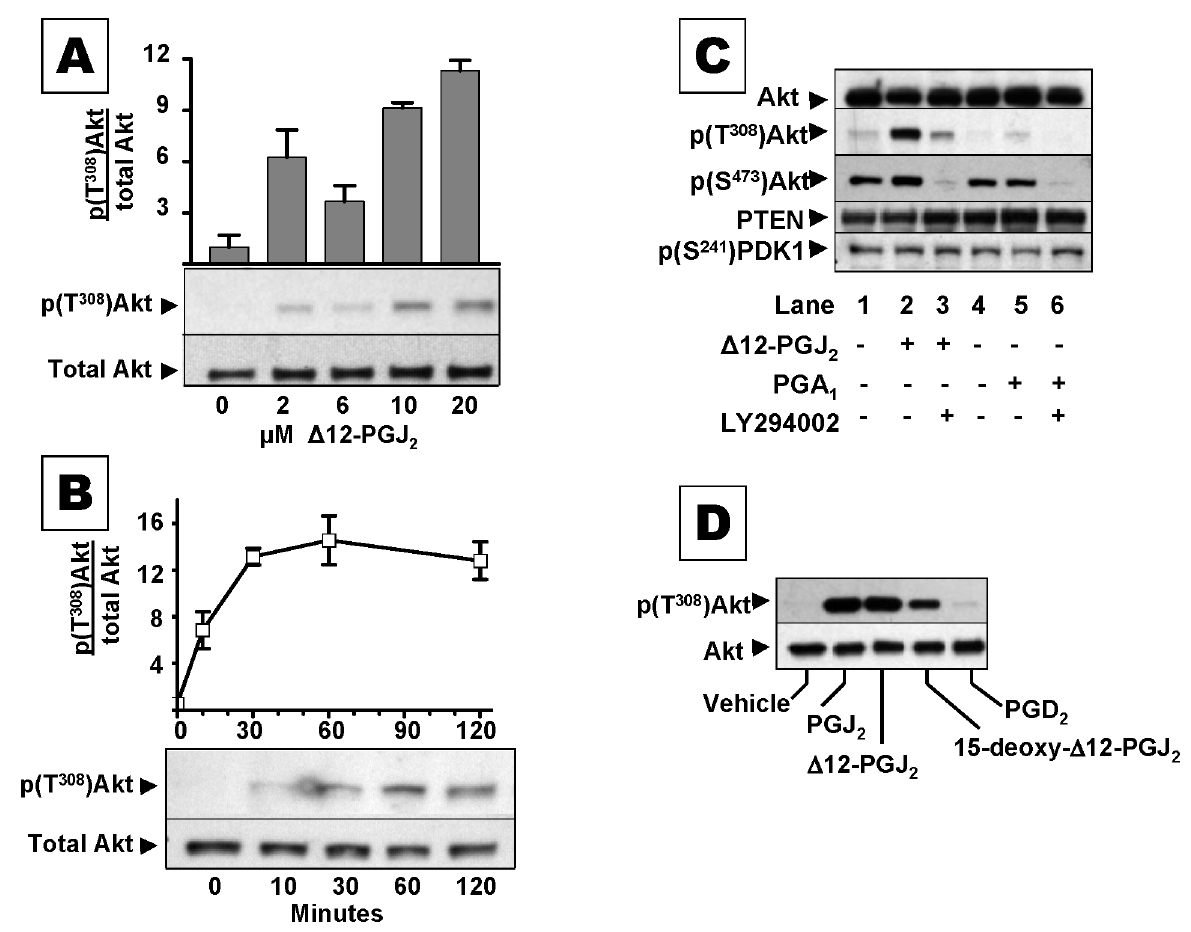
Figure 3. The a , ß–unsaturated enone D 12PGJ 2 interferes with PTEN suppression of Akt activation. ( A ) Immunoblots of phospho- (T 308 )Akt relative to total Akt in lysates from MCF-7 cells treated 30 min with 0–20 m M D 12-PGJ 2 . The bar graph shows the increase in phospho- (T 308 )Akt/total Akt (mean 6 s.e.m) from n $ 3 separate experiments. ( B ) Immunoblot of phospho-(T 308 )Akt relative to total Akt in lysates from MCF-7 cells treated with 20 m M D 12-PGJ 2 for 0–120 min. The bar graph shows the increase in phospho-(T 308 )Akt/total Akt (mean 6 s.e.m) from n=4 separate experiments. ( C ) Immunoblots of total Akt, phospho-(T 308 )Akt, PTEN, phospho-(S 241 )PDK1 from lysates of MCF-7 cells treated 30 min with 20 m M D 12-PGJ 2 (lane 2, 3) and 20 m M PGA 1 (lane 5, 6) in the presence of the PI3-K inhibitor 50 m M Ly294002 (lane 3, 6) or DMSO vehicle (lane 2, 5). ( D ) Immunoblot of phospho-(T 308 )Akt relative to total Akt in lysates from MCF-7 cells treated 4 hrs with vehicle, the cyclopentenones - PGJ 2 , D 12- PGJ 2 , and 15-deoxy- D 12-PGJ 2 , or their precursor PGD 2 . For (C) and (D), blots are representative of results obtained in three independent experiments. doi:10.1371/journal.pone.0013545.g003 Table 1.